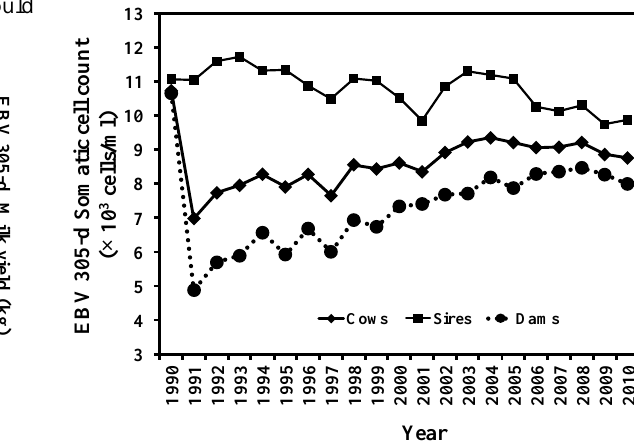
Figure 1. Yearly means of EBV for somatic cell count and milk yield of cows from 1990 to 2010.